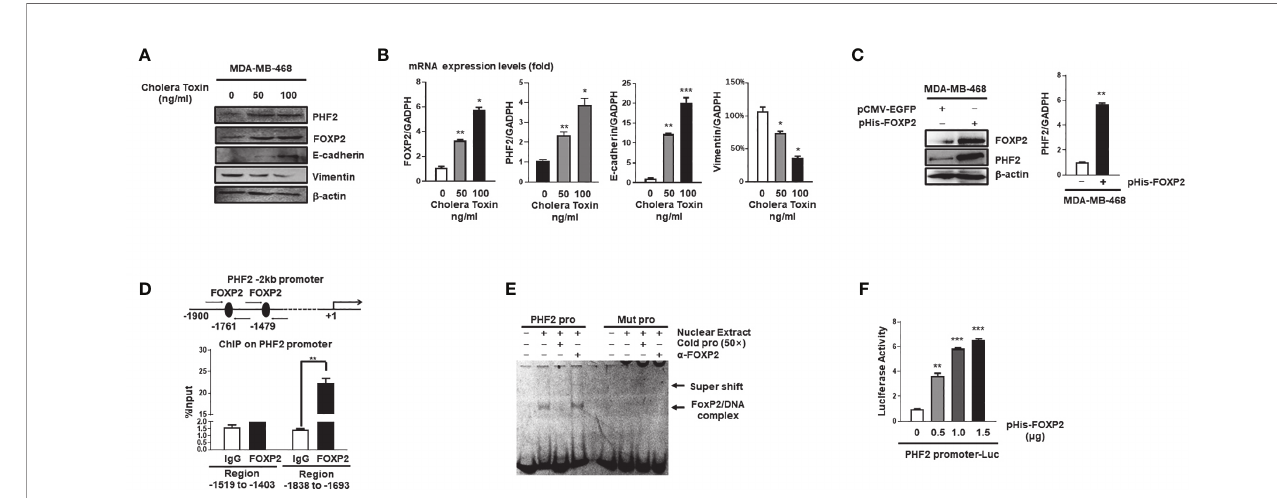
FIGURE 3 | FOXP2 stimulated the expression of PHF2 during MET of breast cancer cells. (A, B) The expression levels of PHF2 and FOXP2 were upregulated during CTx-induced MET of MDA-MB-468 breast cancer cells. MDA-MB-468 cells were treated with different concentrations of CTx (50 or 100 ng/ml) for 7 days. The levels of FOXP2, PHF2, E-cadherin, and Vimentin were examined by Western blotting (A) and qPCR (B) , respectively. (C) The overexpression of FOXP2 stimulated PHF2 expression in MDA-MB-468 cells. MDA-MB-468 cells were transfected with pHis-FOXP2 or pCMV-EGFP. The levels of FOXP2 and PHF2 were examined by Western blotting and qPCR. (D) FOXP2 bound to the endogenous promoter of PHF2. Gene sequence analysis was performed to predict positions of putative FOXP2 binding sites in -2 kb human PHF2 promoter and the primers for ChIP assays were designed. The chromatin of MCF-7 cells was cross-linked, sonicated, and immunoprecipitated (IP) with either FOXP2 antibody or rabbit IgG. The amount of promoter DNA associated with the IP chromatin was measured by qPCR with primers speci fi c to PHF2 promoter regions -1,838 bp to -1,693 bp and -1,519 bp to -1,403 bp. (E) FOXP2 bound to PHF2 promoter region -1,765 bp to -1,743 bp. The nuclear extracts were prepared from pHis-FOXP2-transfected cells and used for EMSAs with a FAM-labeled DNA probe synthesized from PHF2 promoter sequence -1,765 bp to -1,743 bp (PHF2 pro). The unlabeled probe (50×) or 1 m g of FOXP2 antibody ( a -FOXP2) was added to the reaction to show the speci fi city of FOXP2/DNA complex formation. EMSAs with a FAM-labeled mutated probe were also performed (Mut pro). (F) The PHF2 promoter was activated by FOXP2 in breast cancer cells. A luciferase reporter plasmid (1.5 m g) containing the fragment of -2,000 bp to +60 bp of PHF2 promoter and loading control pRL-CMV luciferase reporter plasmid (20 ng) was transfected into MDA-MB-468 cells with different amounts of pHis-FOXP2 (0, 0.5, 1.0, and 1.5 m g, balanced with the different amounts of empty expression vector). Protein lysates were prepared at 48 h following transfection and then used to measure dual luciferase enzyme activities. The asterisks indicate statistically signi fi cant changes: *P ≤ 0.05, **P ≤ 0.01, and ***P ≤